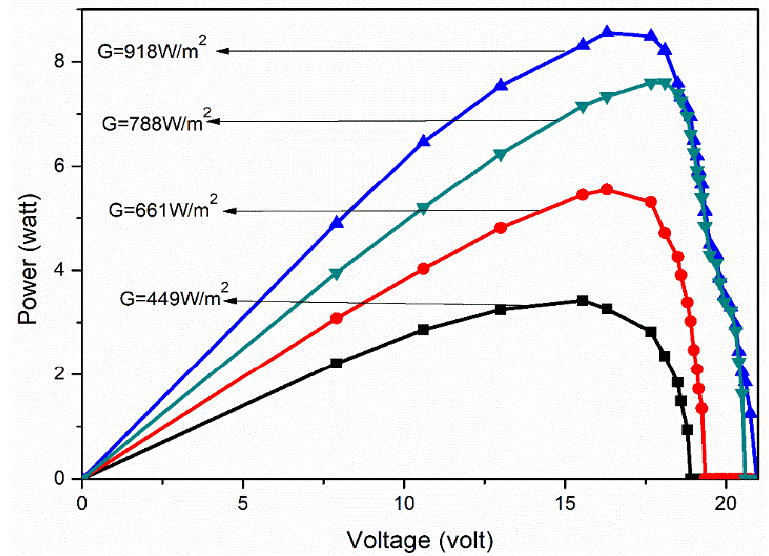
Figure 7. P-V curves of the solar PV panel for different solar irradiance .